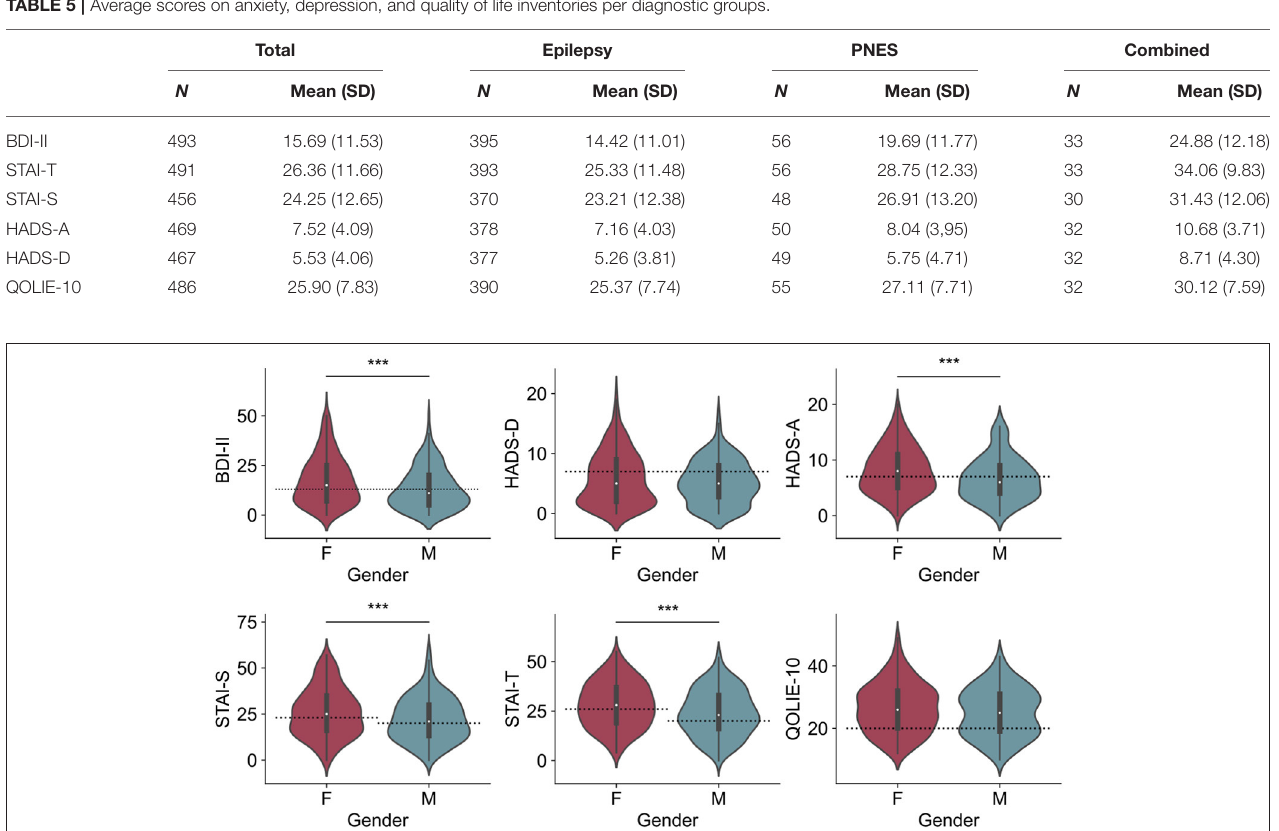
TABLE 5 | Average scores on anxiety, depression, and quality of life inventories per diagnostic groups. Total Epilepsy PNES Combined